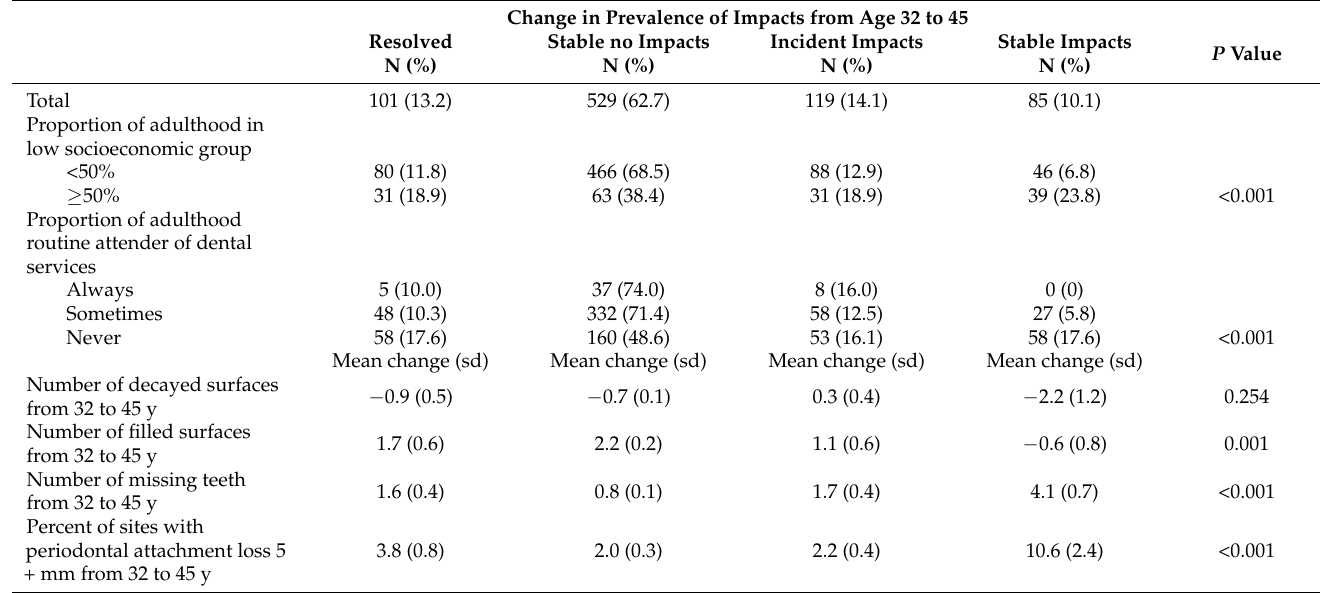
Table 3. Change in impacts on oral health-related quality of life by participant socio-demographic characteristics and experience of oral conditions.